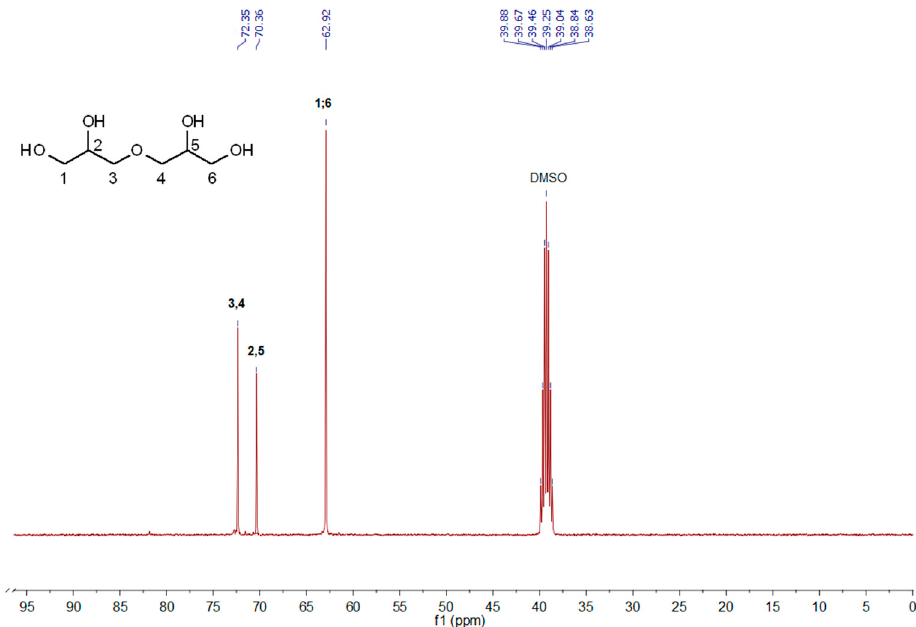
Figure 3. 13 C NMR (100 MHz, DMSO-d 6 ) of oligomerization product obtained by [C 2 -mim][OAc]. During the glycerin oligomerization reaction, its progress was monitored by in-situ recording of the FTIR spectra of the reaction mixture. The set of spectra obtained over time of glycerol oligomerization catalyzed by the ionic liquid [C 12 -mim][OAc] is shown in Figure 4.